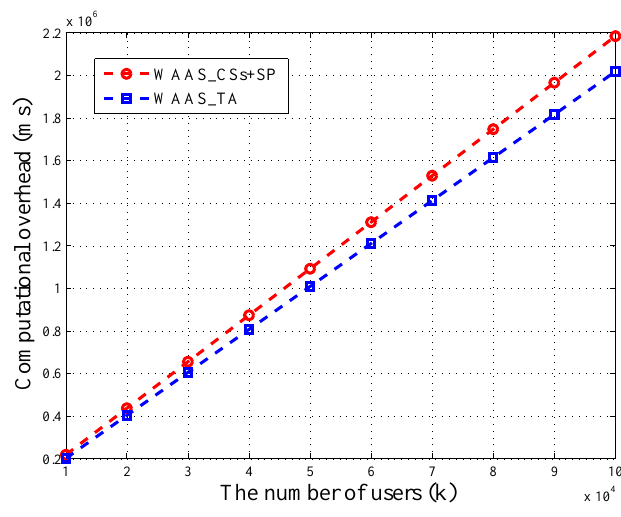
Figure 4. The computational overhead of TA and CSs + SP in